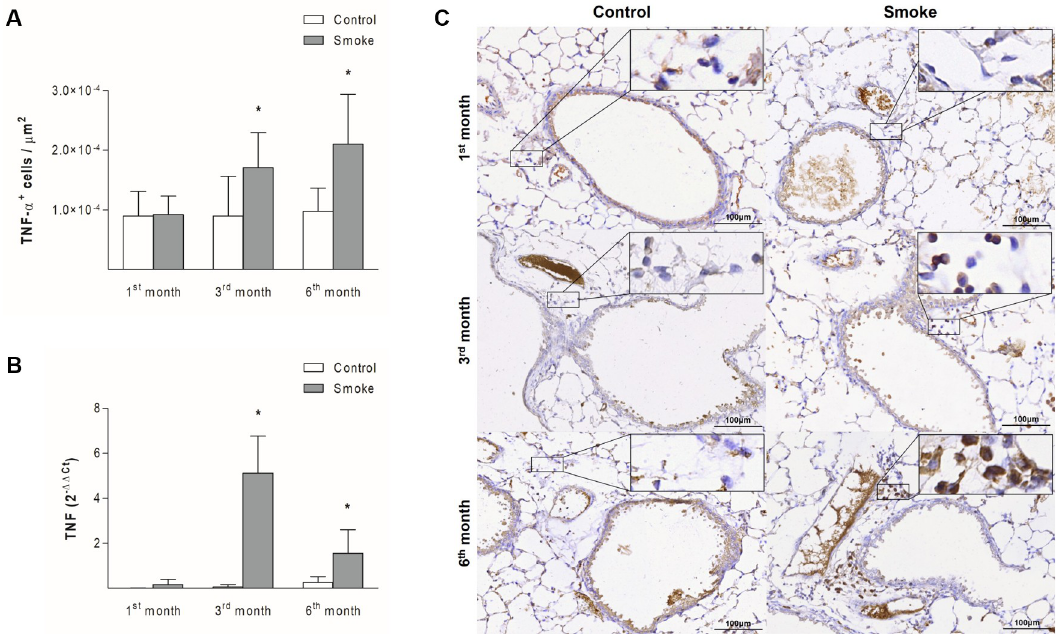
Fig 3. TNF- α expression in peribronchovascular areas and bronchiolar epithelial cells. The numbers of TNF- α + cells in peribronchovascular areas (A) and the TNF gene expression levels in bronchiolar epithelial cells (B) obtained for the Control groups after 1 (n = 10 and 5, respectively), 3 (n = 6 and 5, respectively), and 6 (n = 7 and 4, respectively) months and the Smoke groups after 1 (n = 10 and 5, respectively), 3 (n = 6 and 4, respectively), and 6 (n = 11 and 4, respectively) months are presented as the means ± SDs. (A) Significant differences were found after 3 ( � P = 0.0486, t-test) and 6 ( � P = 0.0066, Mann-Whitney test) months. (B) Significant differences were found after 3 ( � P = 0.0004, t-test) and 6 ( � P = 0.0286, Mann-Whitney test) months. (C) Representative photomicrographs of TNF- α + cells in peribronchovascular areas are shown at 200 × magnification, and images at 1000 × magnification are shown in each insert.